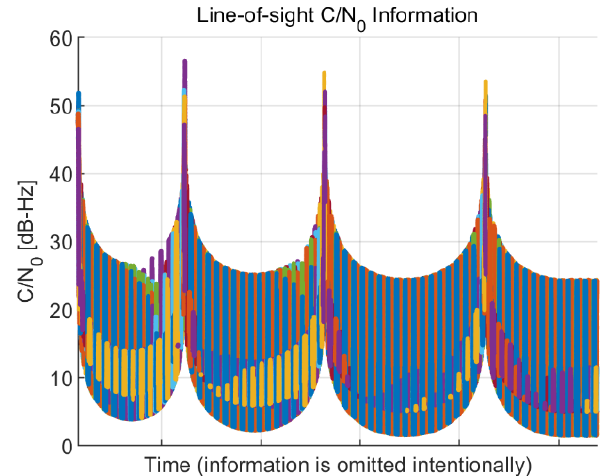
Figure 3. Line-of-sight (LOS) carrier-to-noise-density ratio (C/N 0 ) information of the Moon exploration spacecraft during the mission trajectory. Each color in the figure indicates a different global positioning system (GPS) satellite.